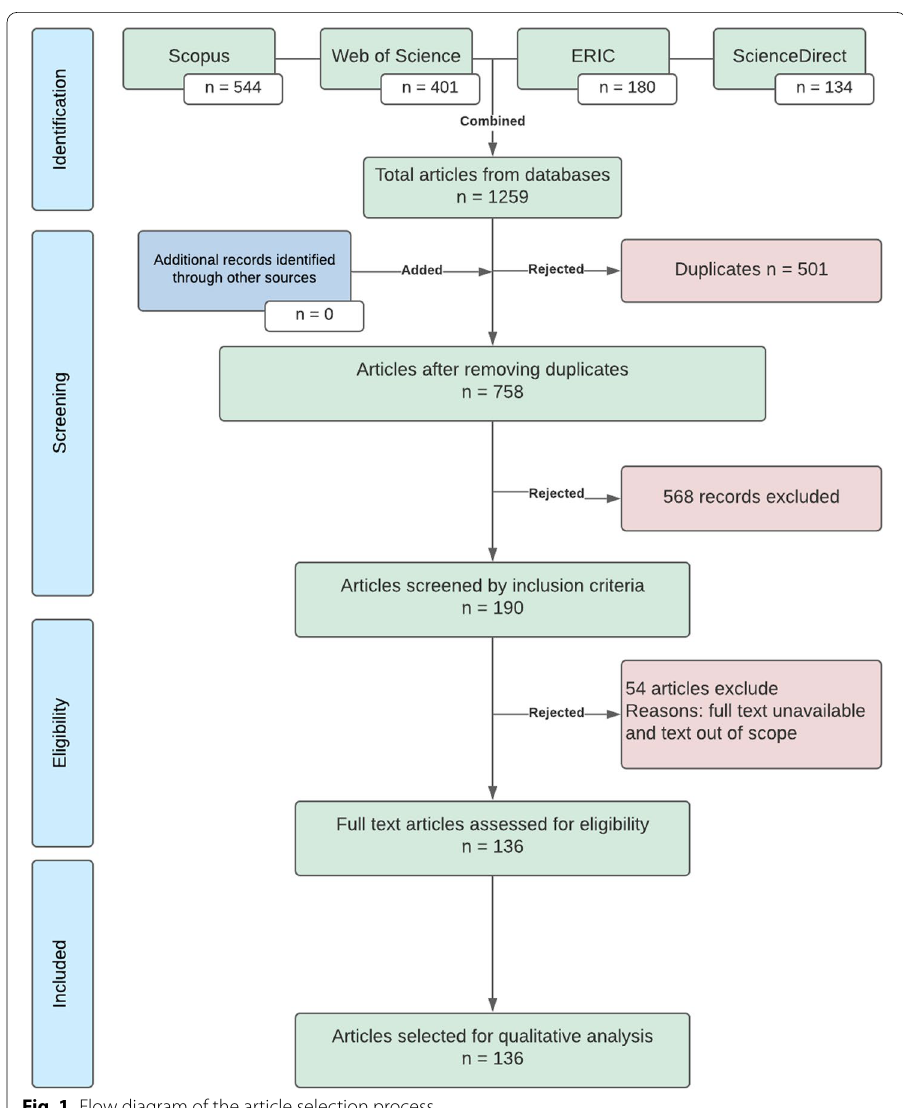
Fig. 1 Flow diagram of the article selection process